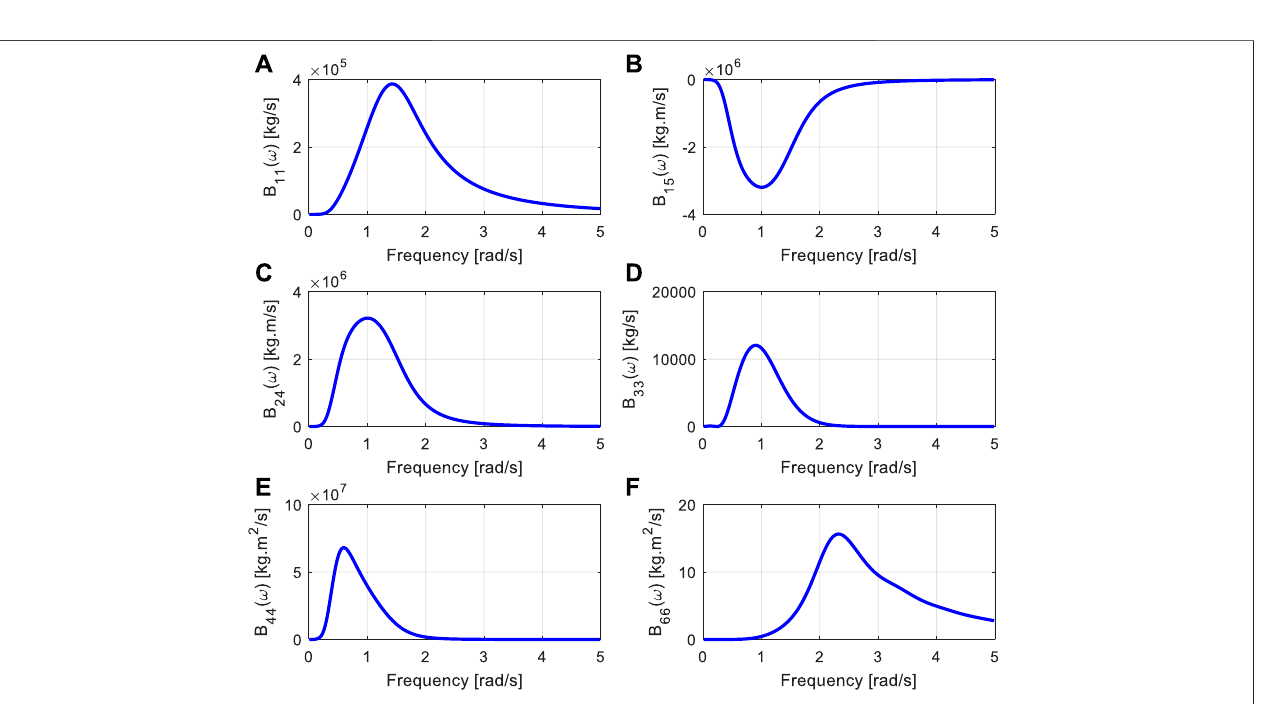
Frontiers in Energy Research |